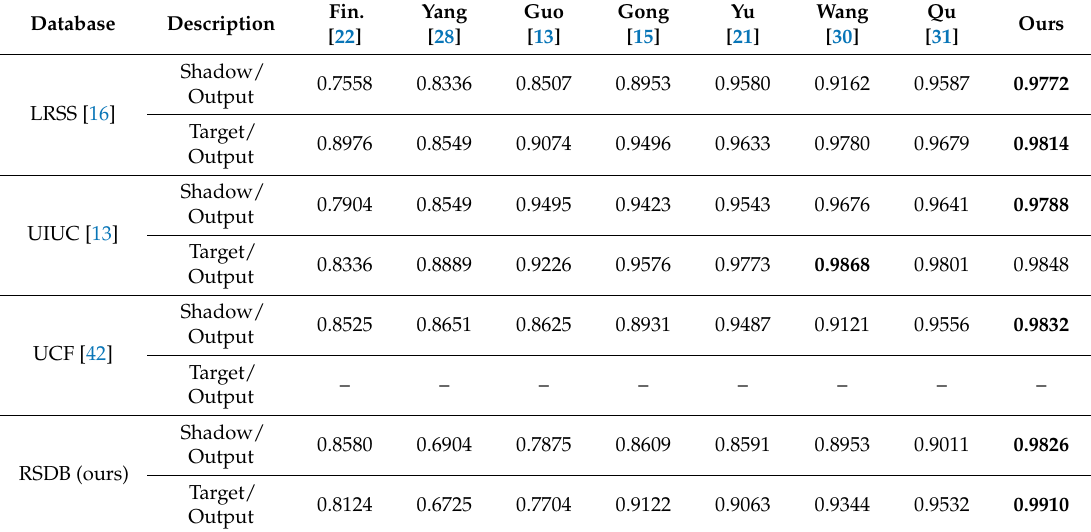
Table 2. Quantitative results using structural similarity (SSIM) (the bigger the better), the maximum value is shown in